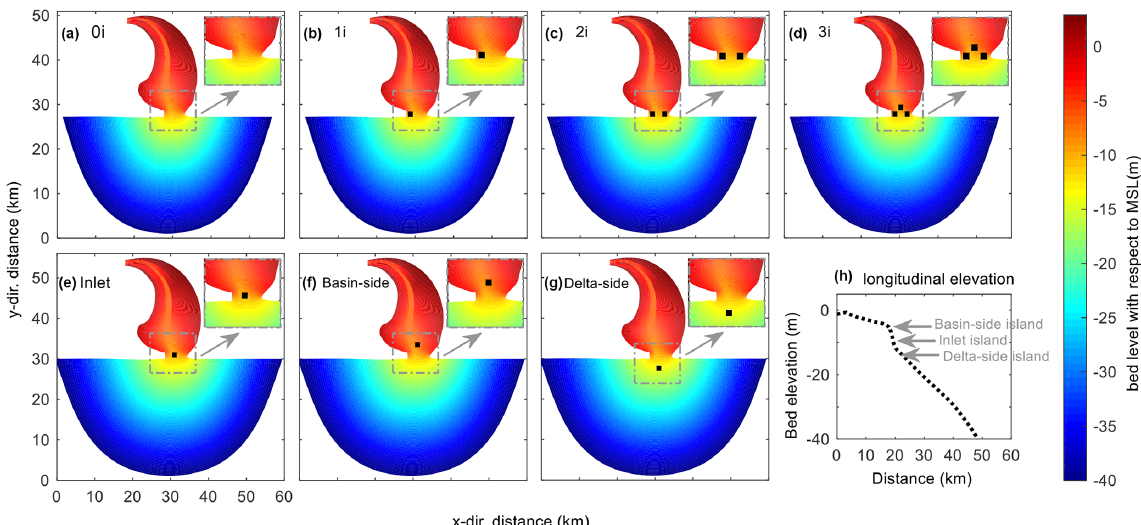
Figure 3. Initial mode domain shape and bathymetry: (a) basin without an island (“0i”); (b) basin with one island (“1i”); (c) basin with two islands (“2i”); (d) basin with three islands (“3i”); (e) the mouth island is at the inlet (“IL”); (f) the mouth island is at the basin side near the inlet (“BS”); (g) the mouth island is at the delta side near the inlet (“DS”); (h) longitudinal profile of the initial bed elevation and the location of mouth islands. In panels (a) – (g) , the solid black area in each plot represents the mouth islands, and we zoom in part of the model domain where there are different island settings. The arrows indicate locations of the mouth islands in the longitudinal profile.